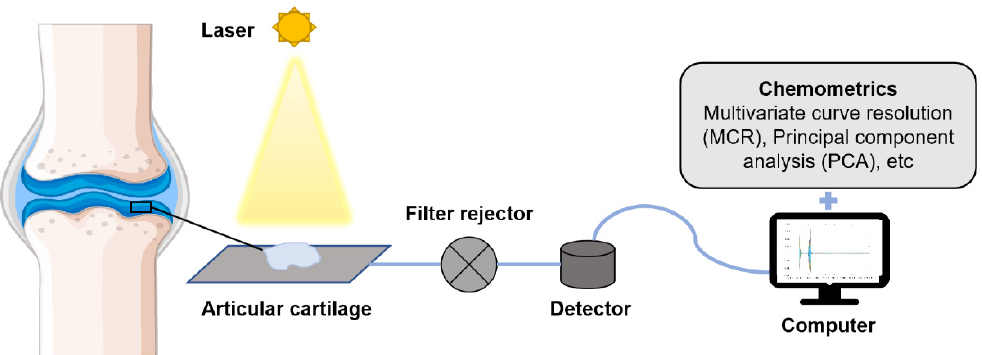
Figure 3. Articular cartilage is detected by Raman spectroscopy. The laser light source irradiates the articular cartilage, and the scattering light is generated through the scattering of the sample. Raman scattering light is obtained by the filter, and the Raman spectrum is presented after its detection and processing by a detector. Spectral data are analyzed with the help of